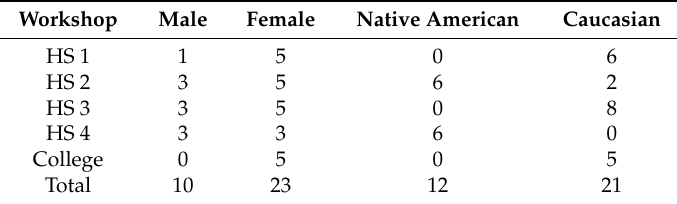
Table 1. Subjects by location, gender, and